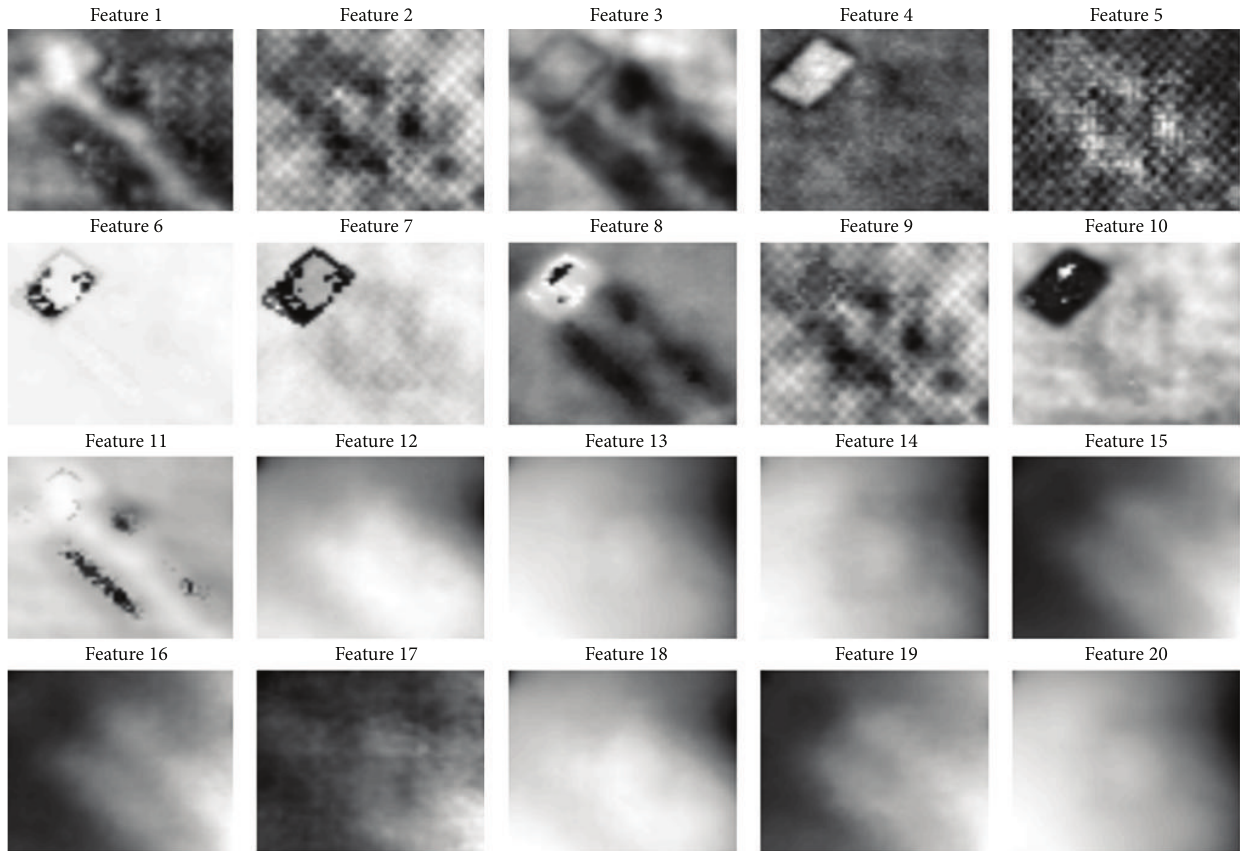
Figure 14: Results of the data registration process carried out for features vector obtained for sample with inclusion